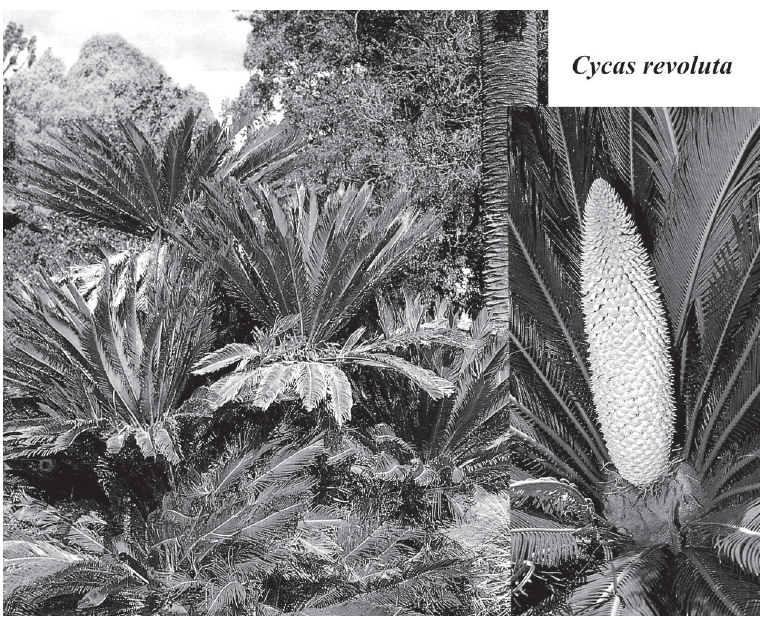
Map 3. Distribution of Cycas in Southeast Asia, Australia, West- ern Pacific Island and Southern Japan. Reproduced from Ref. 36, with permission from Reed New Holland, Sydney,